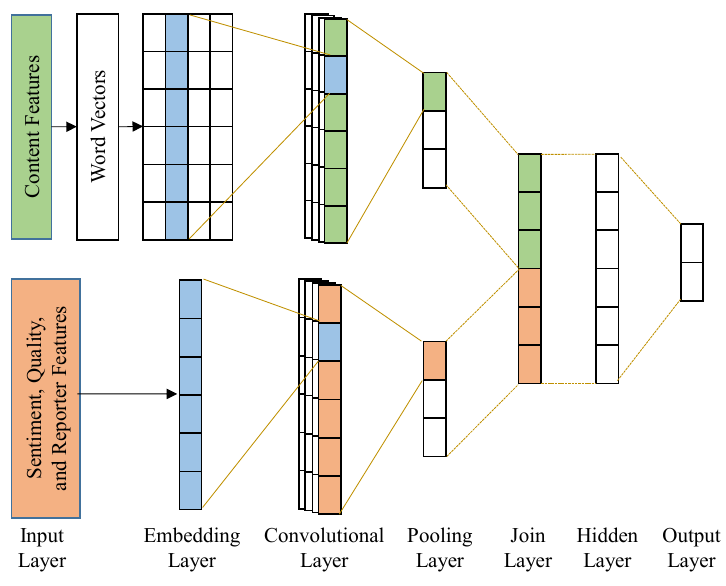
Figure 3. CNN prediction model.